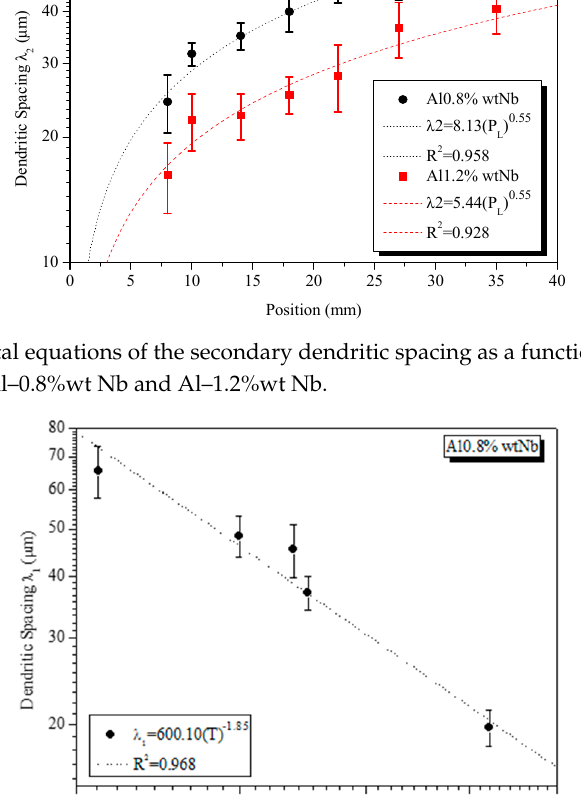
Figure 10. Experimental equation of the primary dendritic spacing as a function of the cooling rate for Al–0.8 Nb (wt.%).